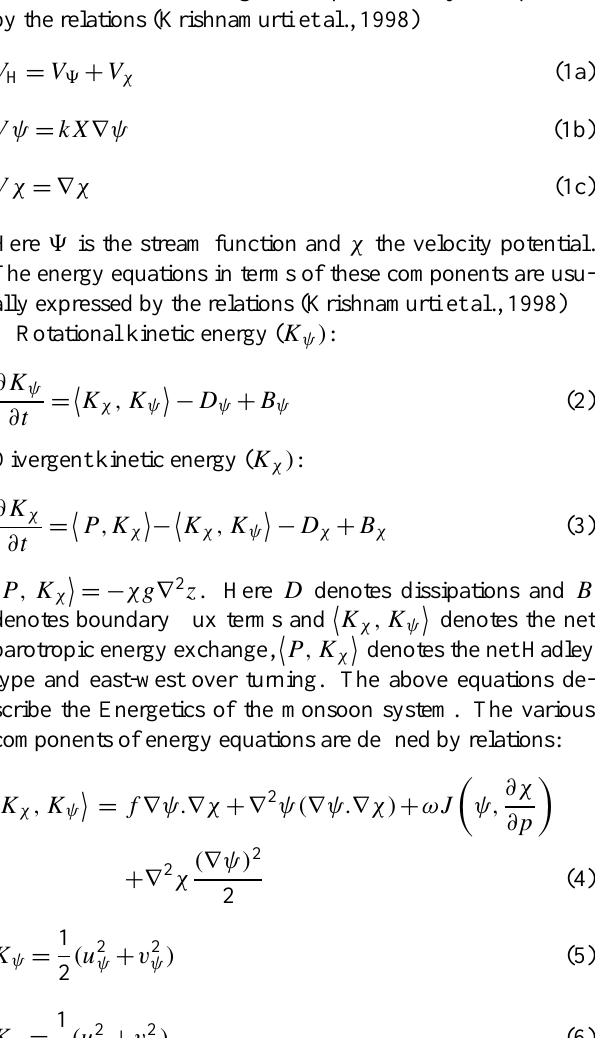
period on a seasonal basis (Jianjun and Guoxiong,